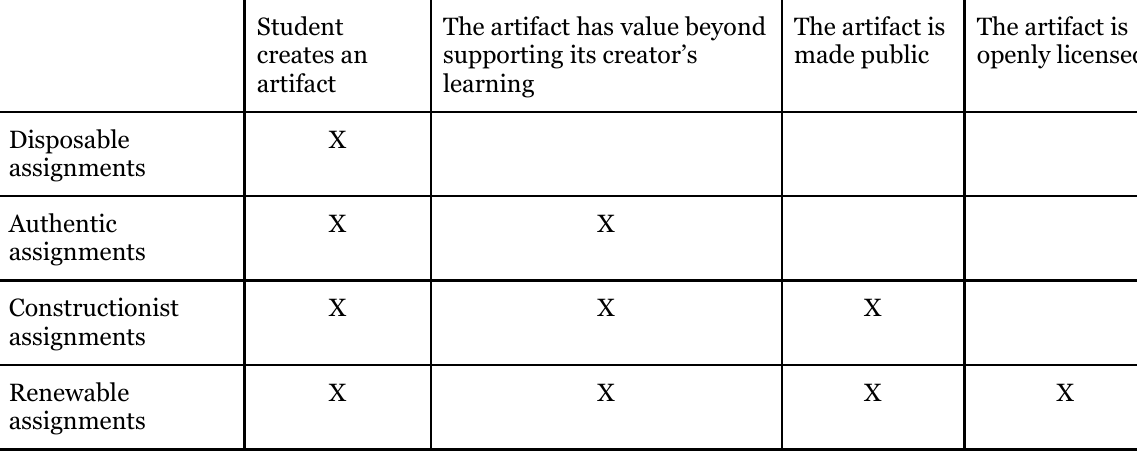
The artifact is